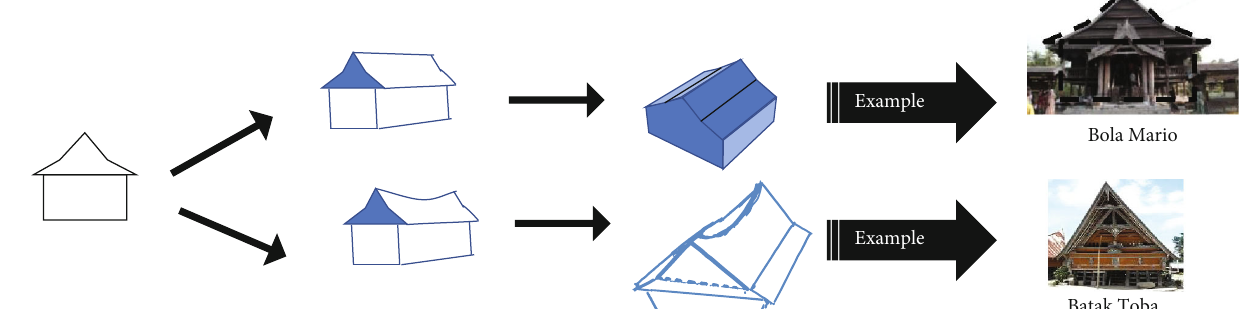
Figure 33: House diagrams of simple house V.